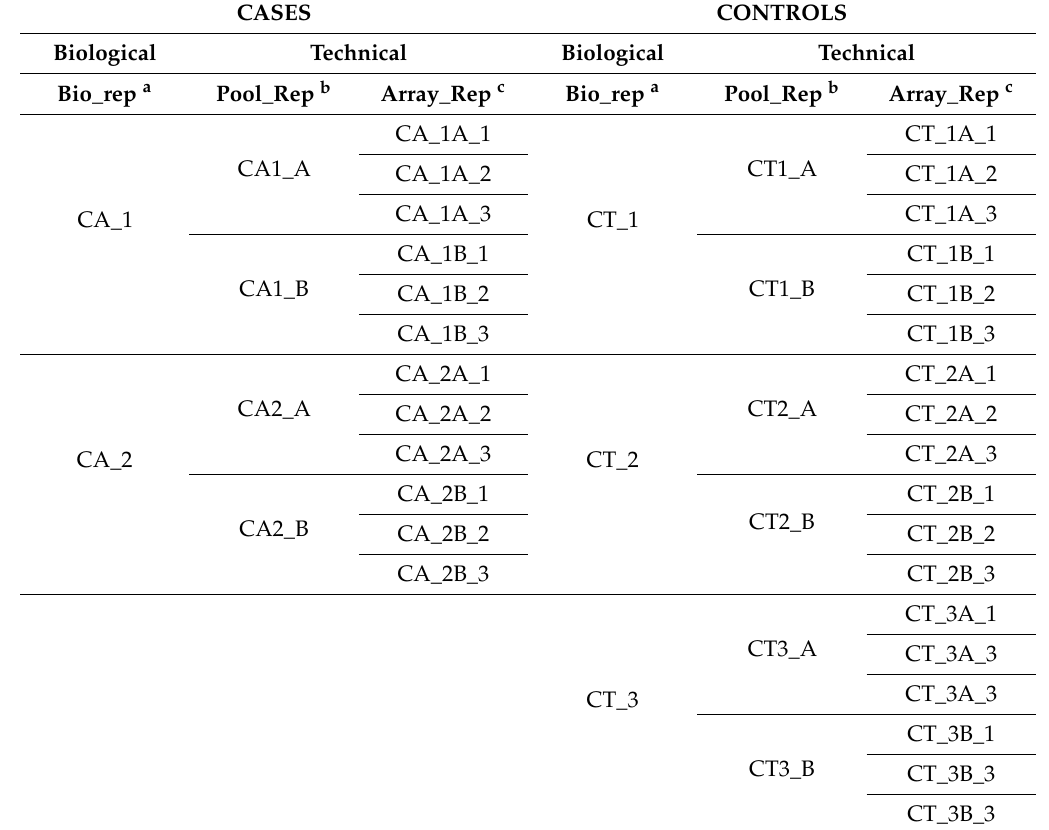
Table 1. Scheme of case (CA) and controls (CT) pool definitions, and of genotyping. CASES CONTROLS